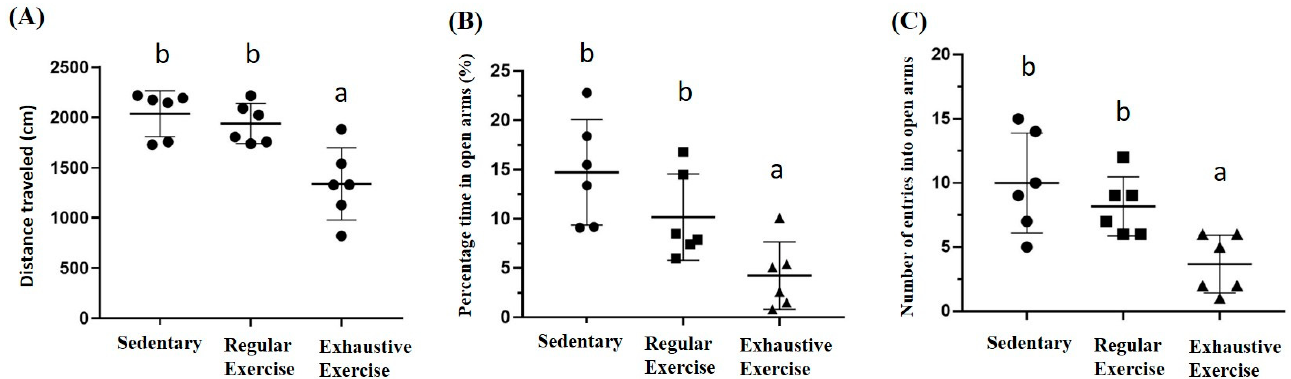
Figure 7. The effects of eight weeks indicated exercise training intervention on locomotor activity levels, and anxiety status after indicated training interventions. Locomotor activity levels ( A ), percentage of time spent in open arms (%) of the elevated plus maze ( B ), and number of entries into the open arms of the elevated plus maze ( C ) were analyzed by Actual Tract software. Data are represented as mean ± SD and the columns with different letters (a, b) represented the significant difference between groups ( p < 0.05) by using one-way ANOVA.